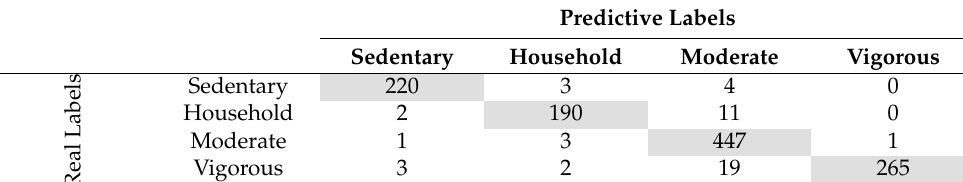
Table 5. The Confusion matrix of the four activity intensity labels among RF algorithm.